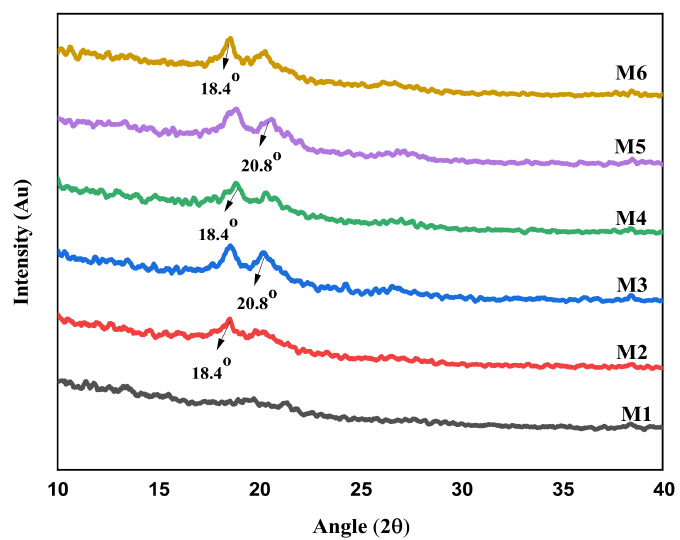
Figure 6. XRD analysis of aminated graphene oxide (AGO) based PVDF membranes.